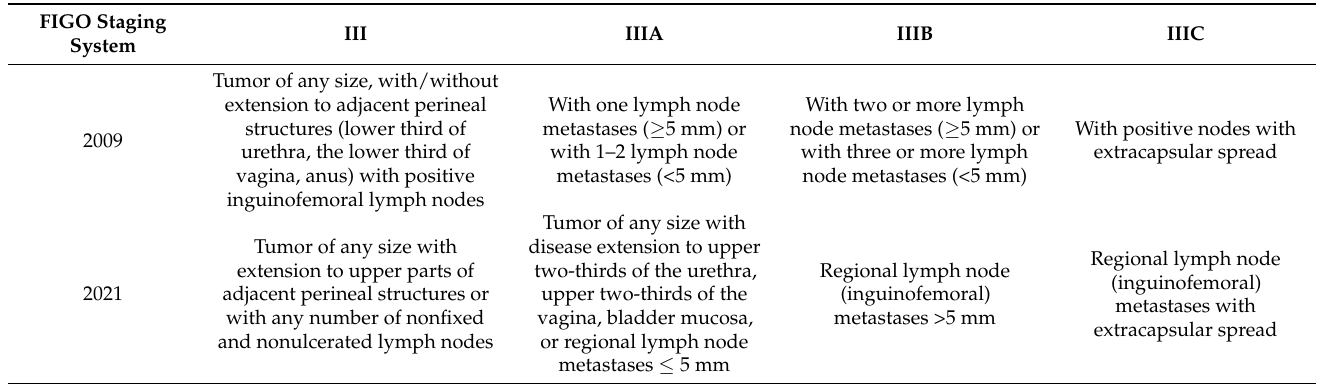
Table 5. International Federation of Gynecology and Obstetrics (FIGO) stage III definitions. FIGO Staging